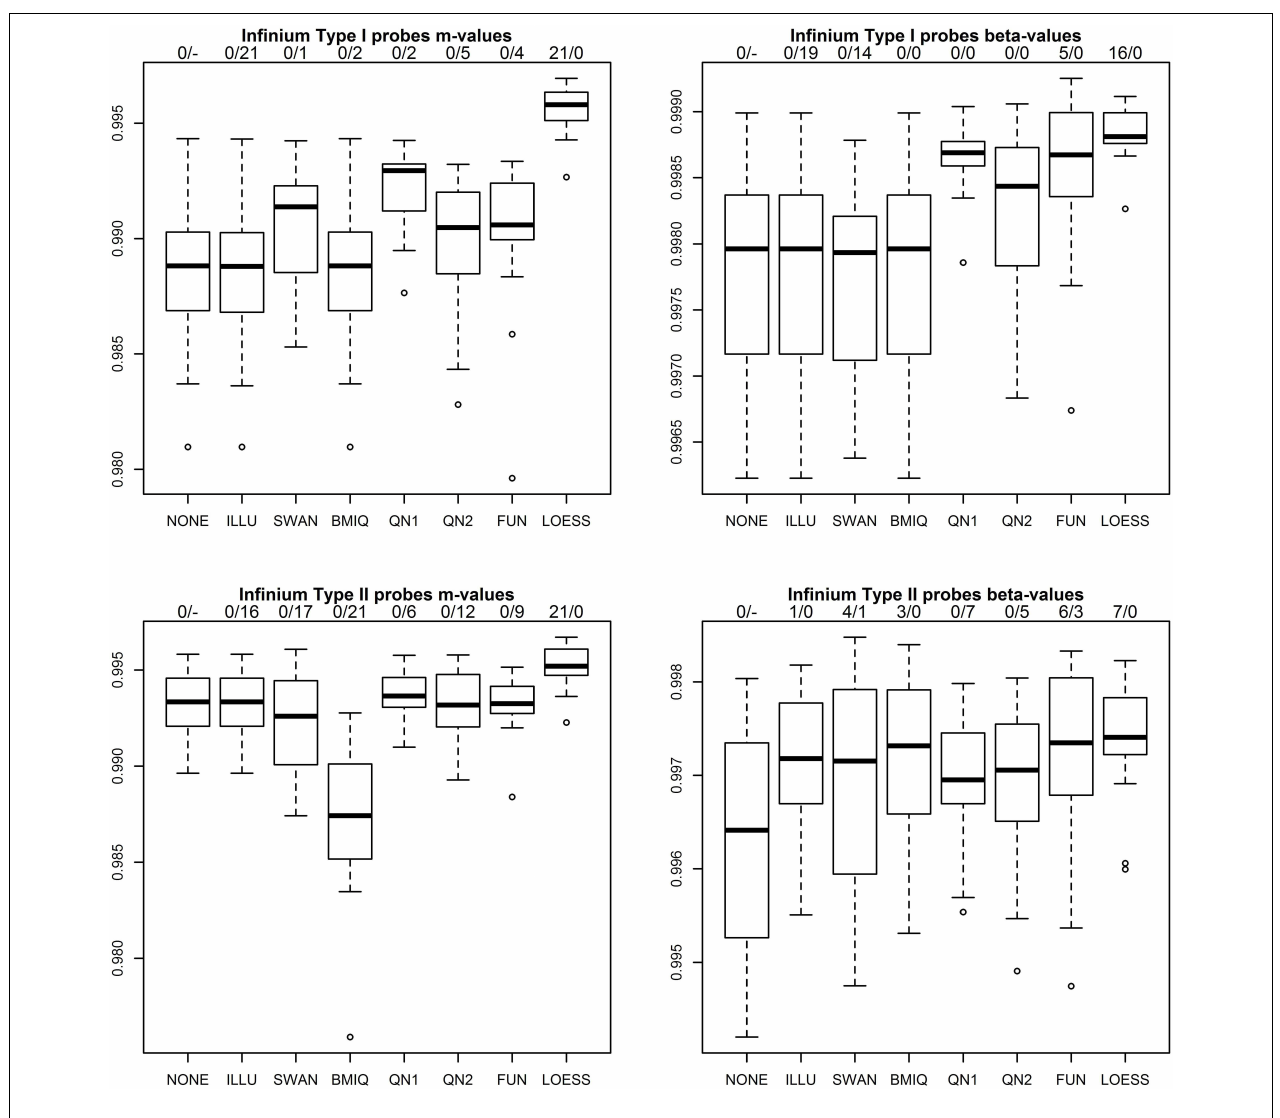
FIGURE 3 | Correlation of m -values and β -values between technical replicates after various normalization methods for P 1 (top row) and P 2 (bottom row). Methods used include raw values (NONE), the standard method in the GenomeStudio software from the chip manufacturer (ILLU), the SWAN method (Maksimovic et al., 2012), the BMIQ method (Teschendorff et al., 2013), quantile normalization